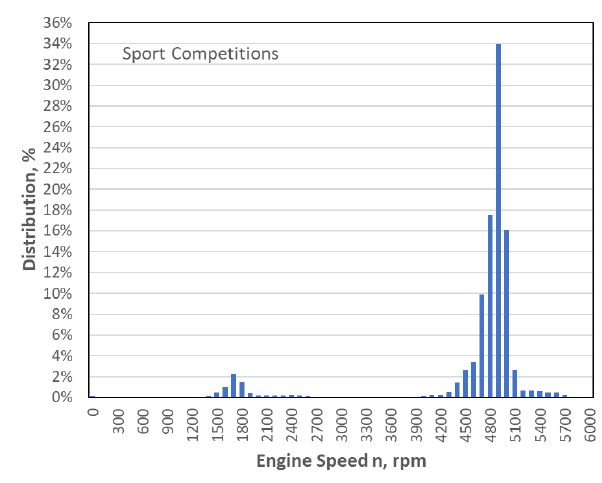
Fig. 7. Distribution of engine speed during the sport competition For the sport competition flights (Fig. 7), the spread of engine speed occurrences is much smaller. Most of the time the engine was running in the 4700–4800 rpm range: 34%. This is the point corresponding to 75% of nominal power being the optimum flight speed for this model of autogyro. Due to the small number of take-offs and landings and the engine warm-up process, the speed ranges corresponding to these states occur much less frequently. Idle is only 4%, warm-up is 1.5% and take-off power is 1.4%. Similar distributions are seen when the manifold air pressure is analyzed (Figs 8 and 9). For training flights (Fig. 8), the most common pressure is the 35–40 kPa range corresponding to engine idle. This occurs for 14.5% of the engine operating time. The pressure ranges from 100 to 120 kPa occur with a similar frequency of about 6–8%.